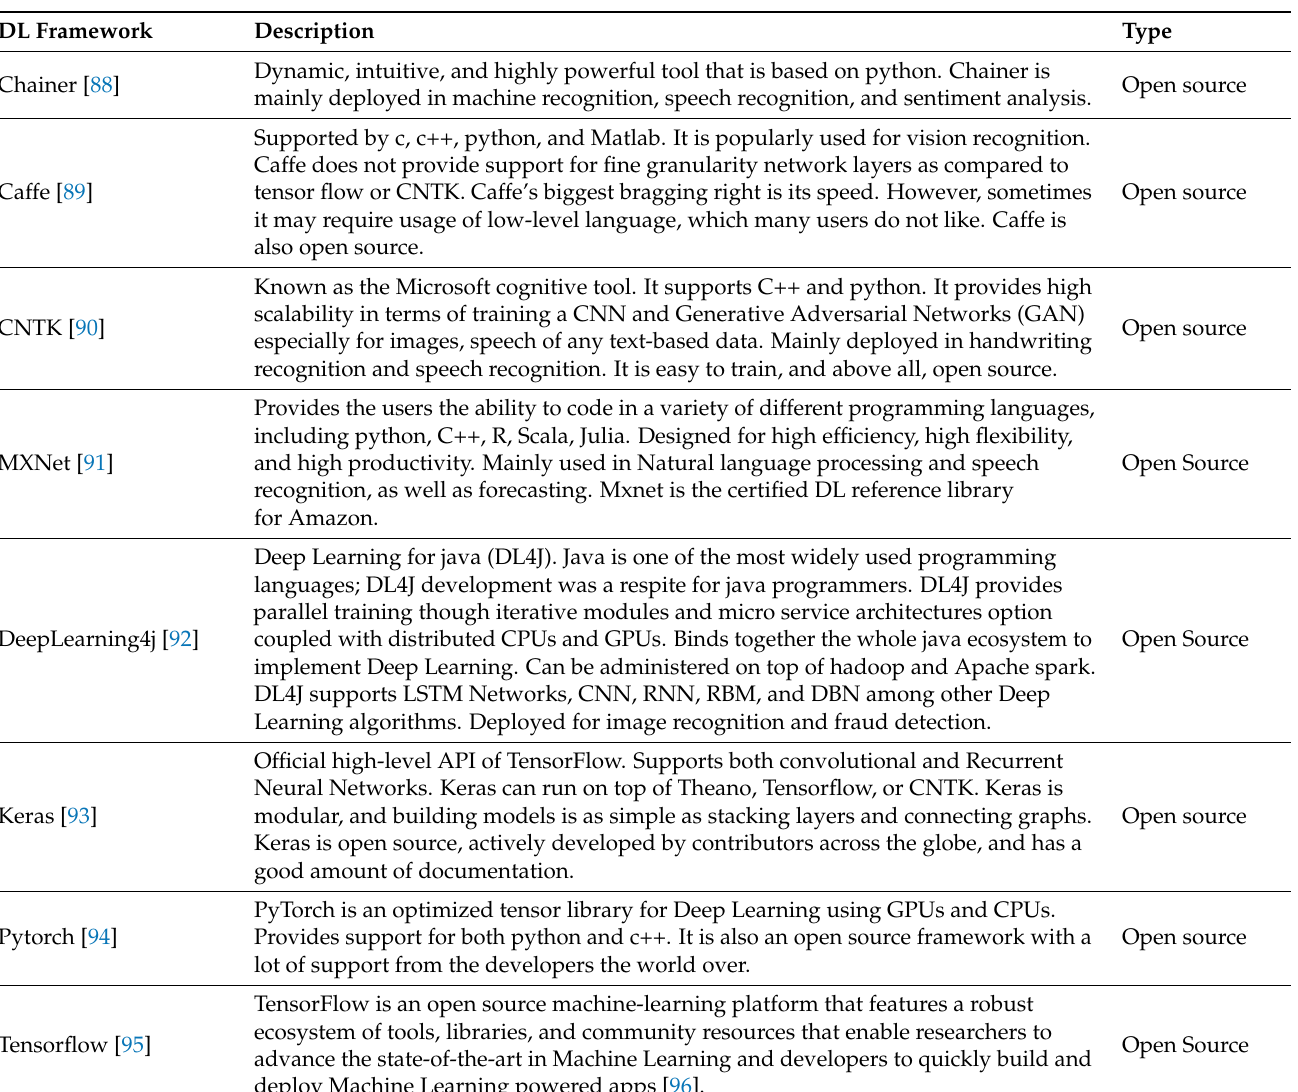
Table 2. Deep Learning